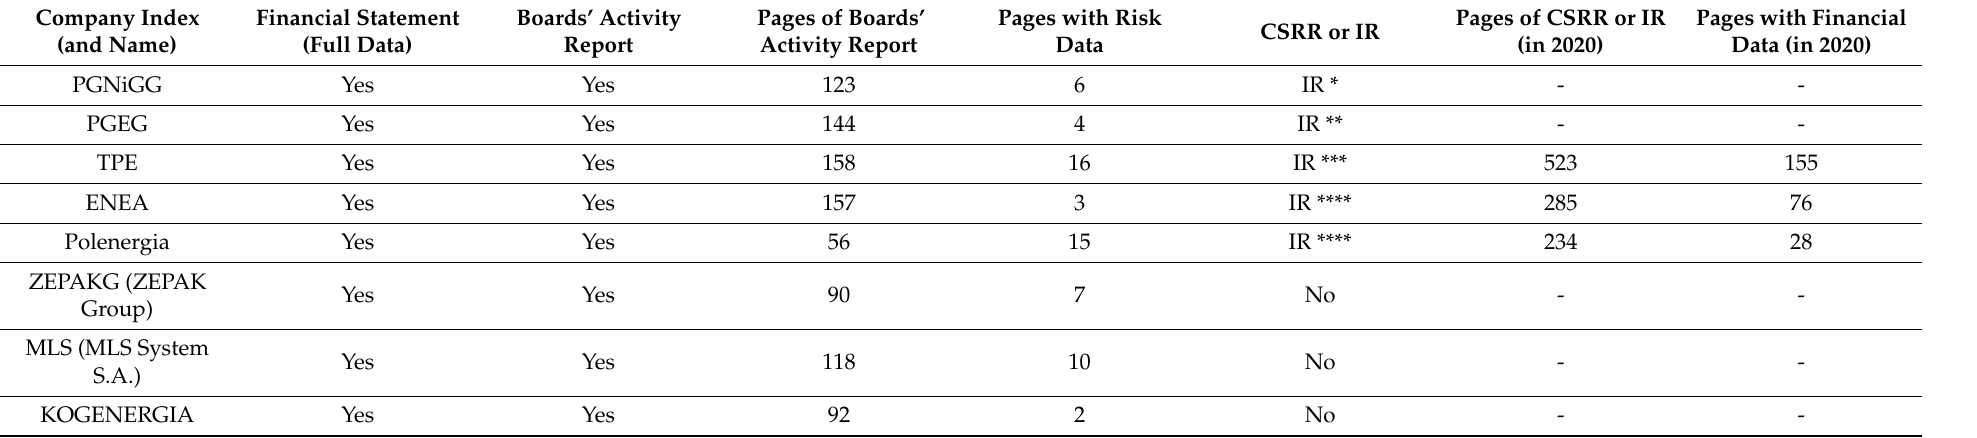
Table 4. Data on analysed corporate annual reports of WSE-listed companies operating in the energy sector